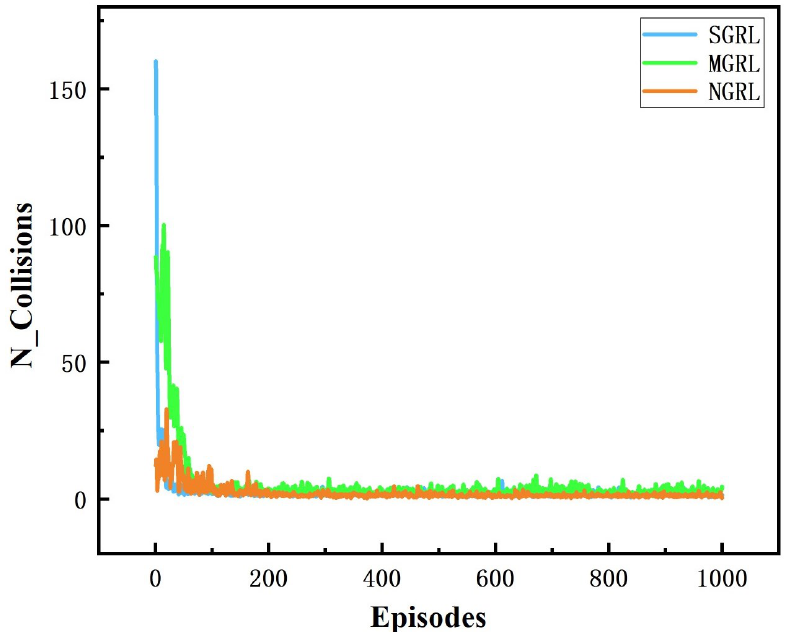
Figure 15. Diagram of collisions. This value is the number of collisions between vehicles obtained by real-time detection in the simulation scenario.